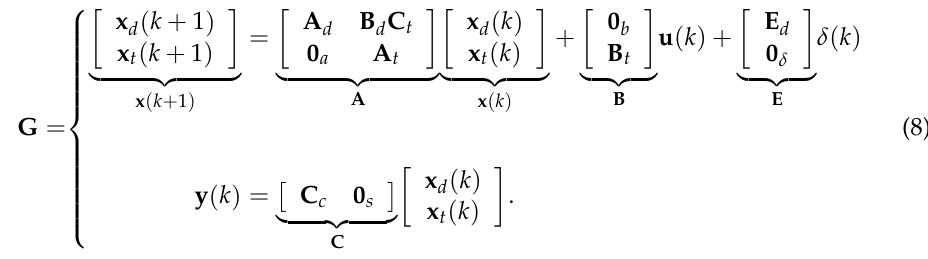
Figure 4. Current directions for node analysis in the DC link.